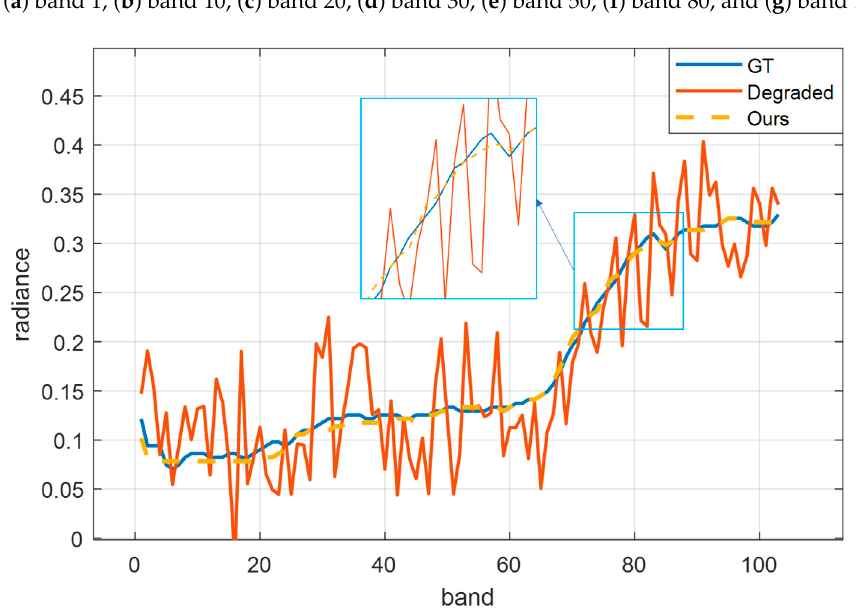
Figure 5. The spectral curve at (311,311) in the PaviaU dataset. Blue represents the original spectral curve, red represents the spectral curve of degraded data, and yellow represents the spectral curve after quality improvement.